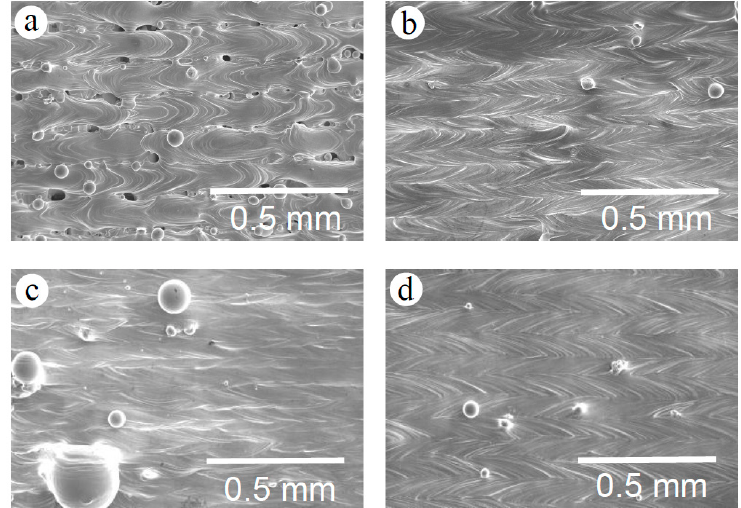
Figure 4. SEM micrographs of the polished surface of the as-built Zr-1Mo alloys with various energy densities: ( a ) 26.4 J·mm − 3 ; ( b ) 60.3 J·mm − 3 ; ( c , d ) 84.4 J·mm − 3 : ( c ) balling particle, ( d ) sputter particle; and